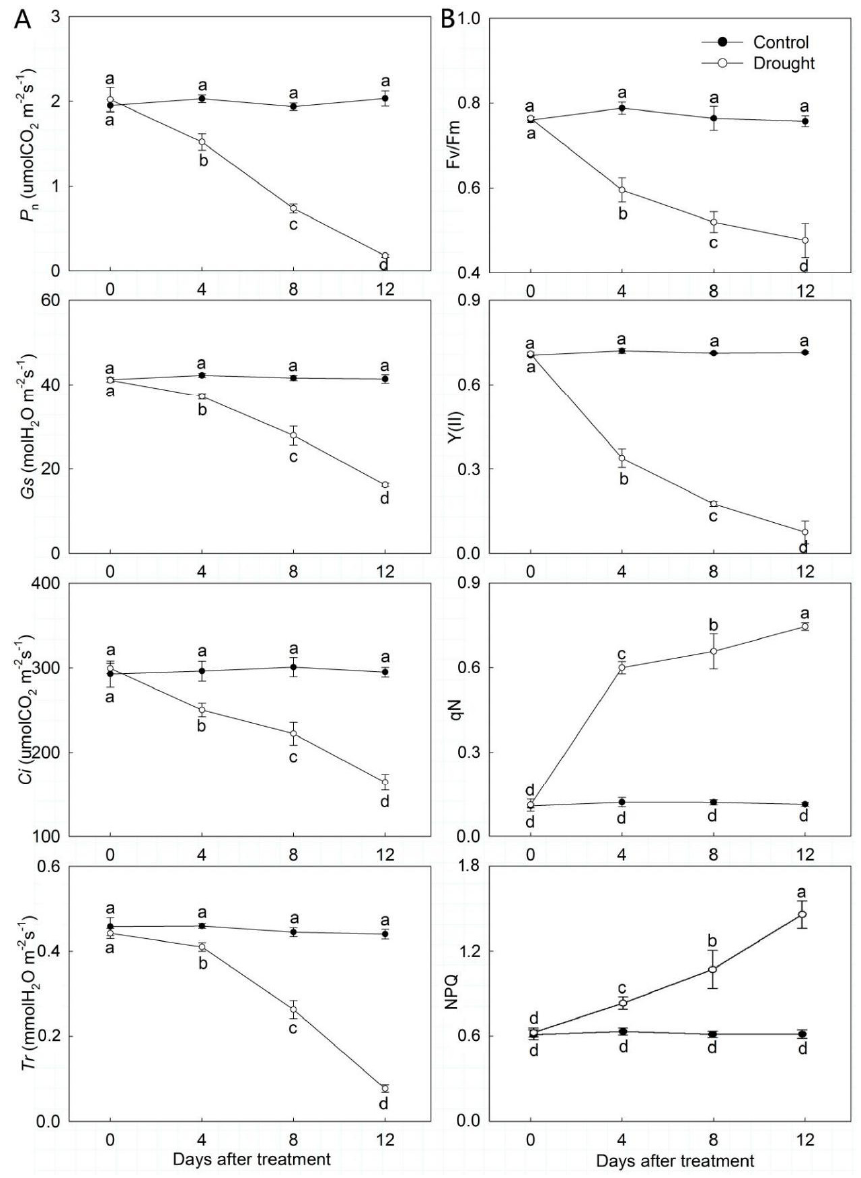
Figure 4. Photosynthetic characteristics and chlorophyll fluorescence parameters changes of drought- treated P. ostii and the control. ( A ) Photosynthetic characteristics. ( B ) Chlorophyll fluorescence parameters. Values represent mean ± standard deviation (SD), and letters indicate significant differences according to Duncan’s multiple range test ( p < 0.05). P n , Net photosynthesis rate; T r , transpiration rate; C i , intercellular CO 2 concentration; G s , stomatal conduction; NPQ, non-photochemical quenching; qN, non-photochemical chlorophyll fluorescence quenching; Fv, variable fluorescence; Fm, maximum fluorescence; Y(II), photosynthetic efficiency of photosystem II.